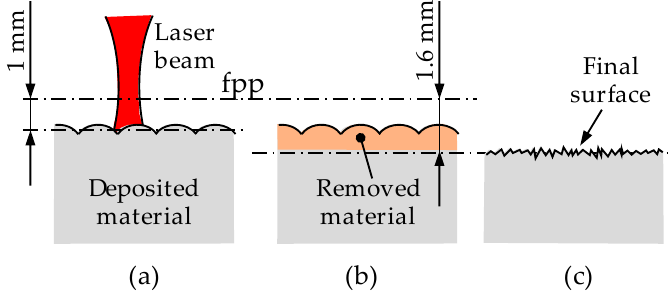
Figure 8. Followed strategy in LBM for obtaining a flat surface from the waved LMD surface. ( a ) LMD manufactured part; ( b ) Material removal via LBM; ( c ) Resulting flat surface after LBM.